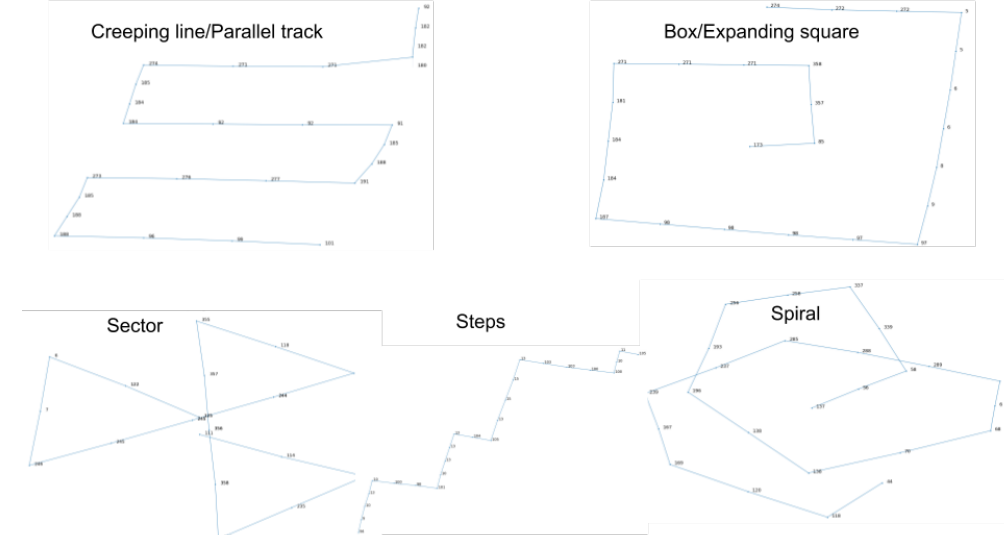
Figure 1. The different types of search and rescue